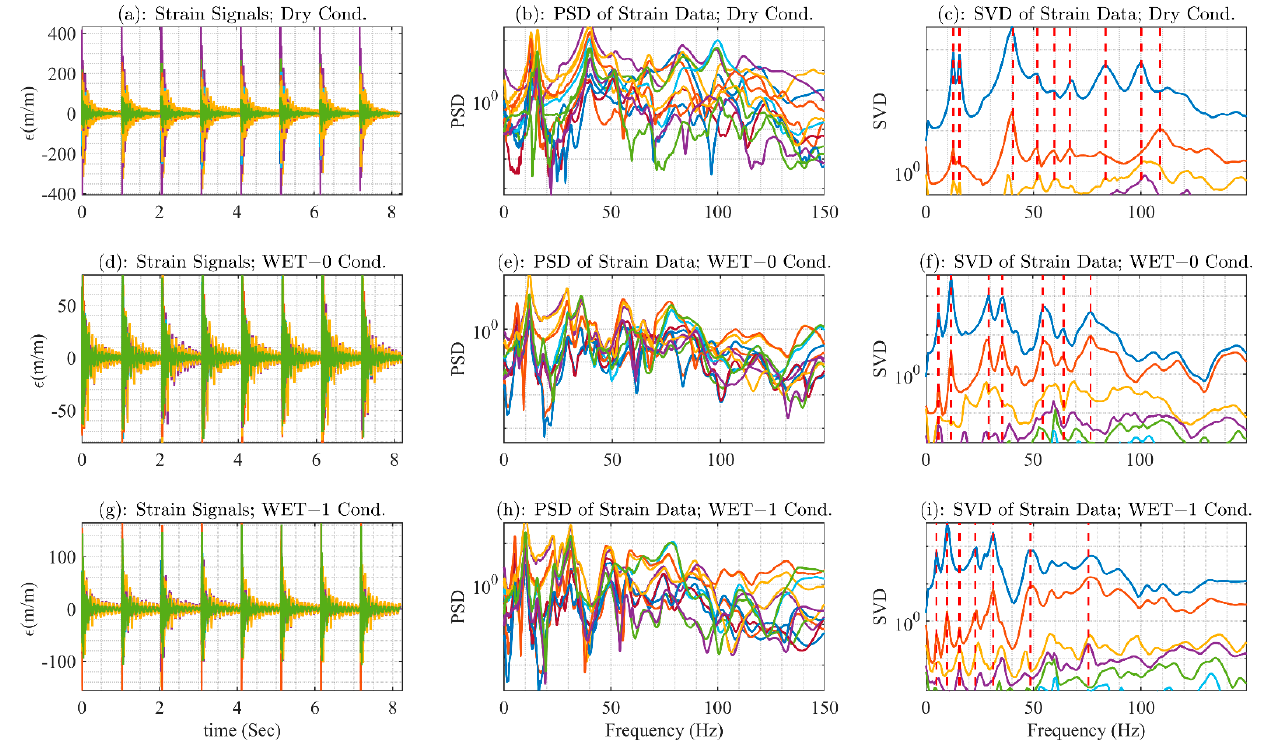
Figure 10. Strain data from experimental setup of the small-scale model for NFs extraction by FDD and SVD. The first column ( a , d , g ) shows the strain signals for the dry, semi-inundated, and fully inundated cases, respectively; the second column ( b , e , h ) shows the strain PSD signals for the dry, semi-inundated, and fully inundated cases, respectively; the third column ( c , f , i ) shows the strain SVD signals with detected system poles indicated by vertical dashed lines, passing through the peaks of the SVD signals, for the dry, semi-inundated, and fully inundated cases, respectively.